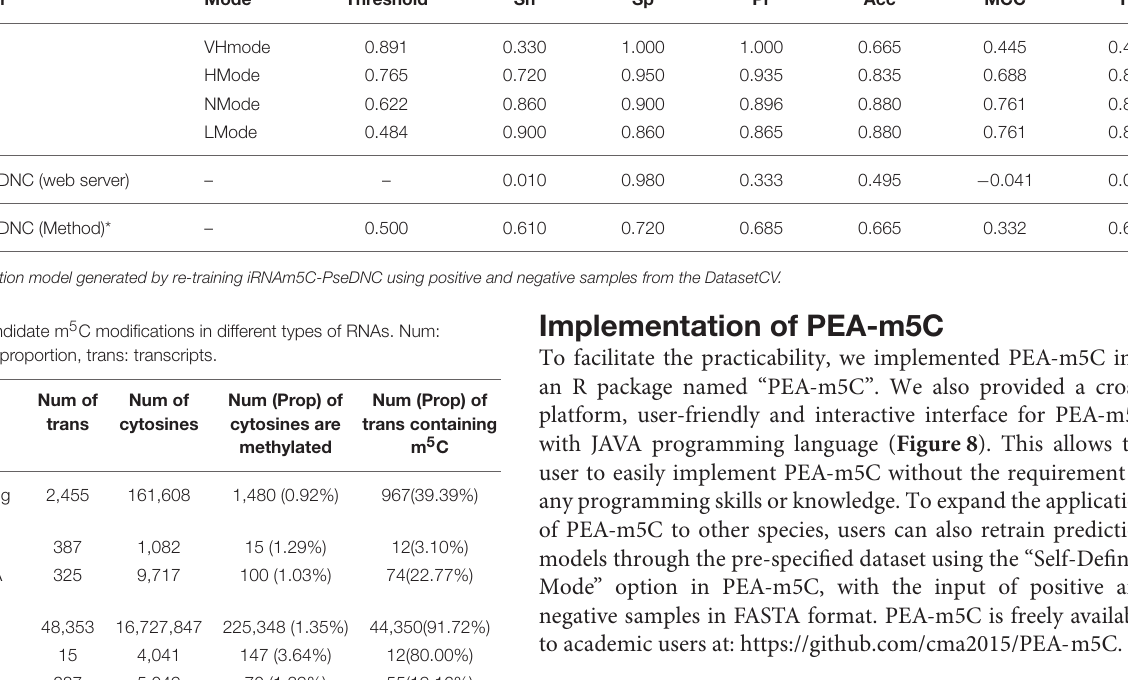
TABLE 1 | Prediction performance of m 5 C predictors on DatasetHT. m 5 C predictor